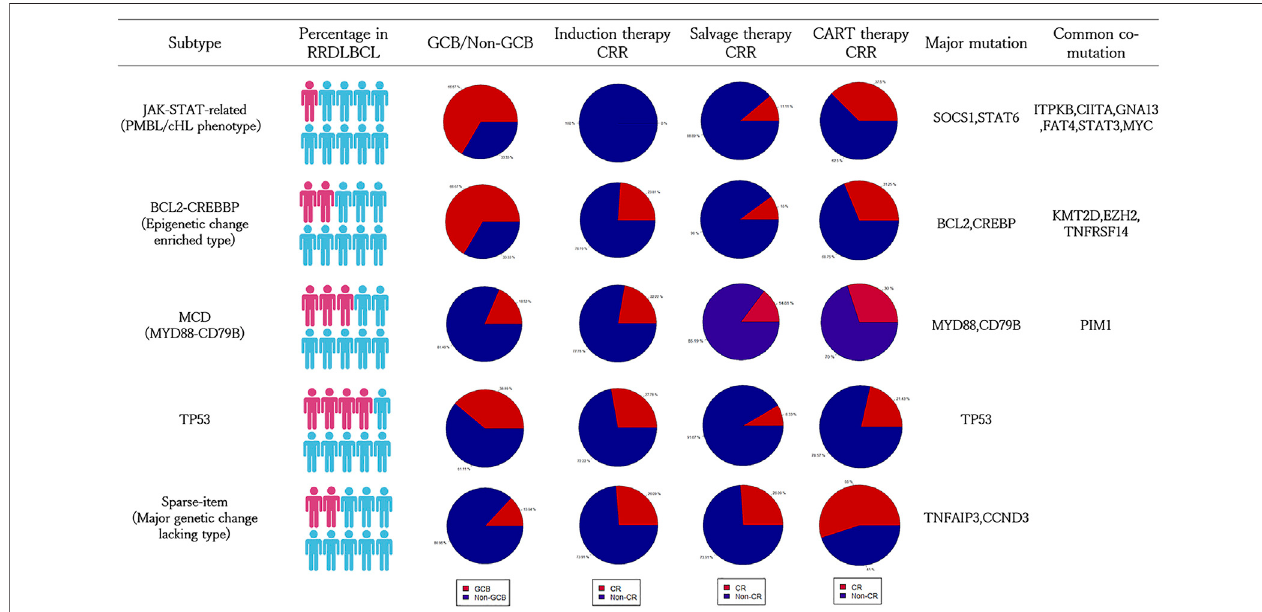
FIGURE 5 | Summary of clinical information of the fi ve subtype classi fi cation systems of RRDLBCL. The clinical information is based on 96 patients in the targeted sequencing cohort. Speci fi c data can refer to the Supplementary Tables S2, S3 .